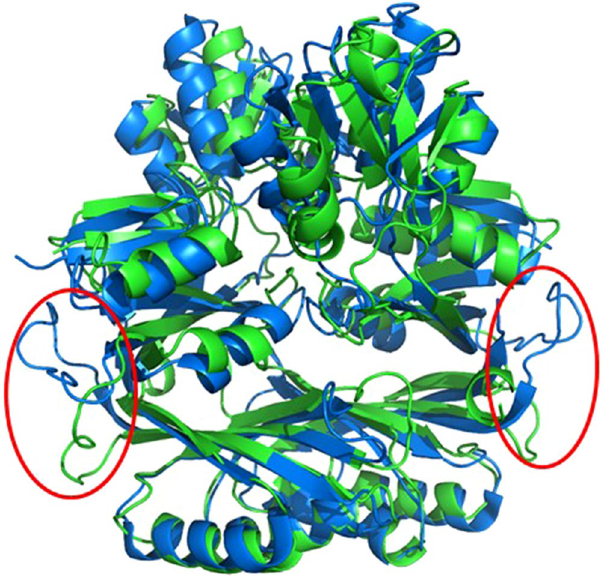
Figure 8. Superposition of GqqA and the prephenate dehydratase (2qmx). The structures of GqqA (green) and 2qmx (blue) share the same fold but the domains are in a different orientation to each other. The main difference is located at the loop between both functional units (red circles) which have completely different sequences and